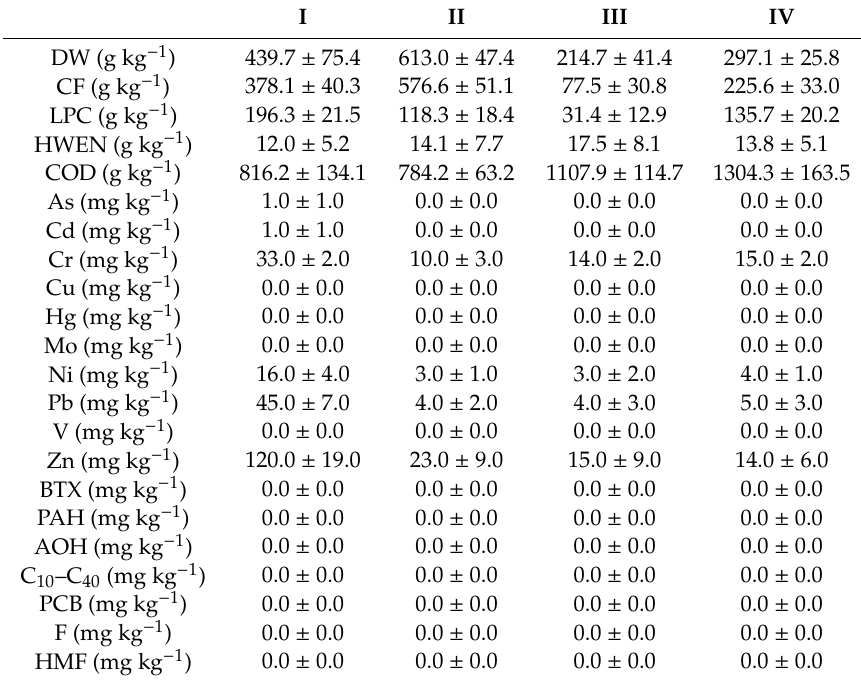
Table 3. Characteristics of feedstock used for anaerobic fermentation and composting (converted to DM), where: I = public greenery, II = postharvest residues, III = cattle manure and IV = maize silage, p -value =